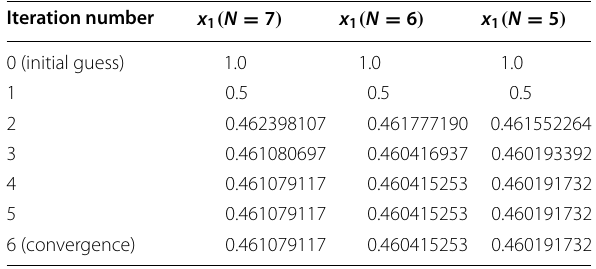
Table 4 Rayleigh–Ritz convergence of contact length x 1 at q = q 1 for various N